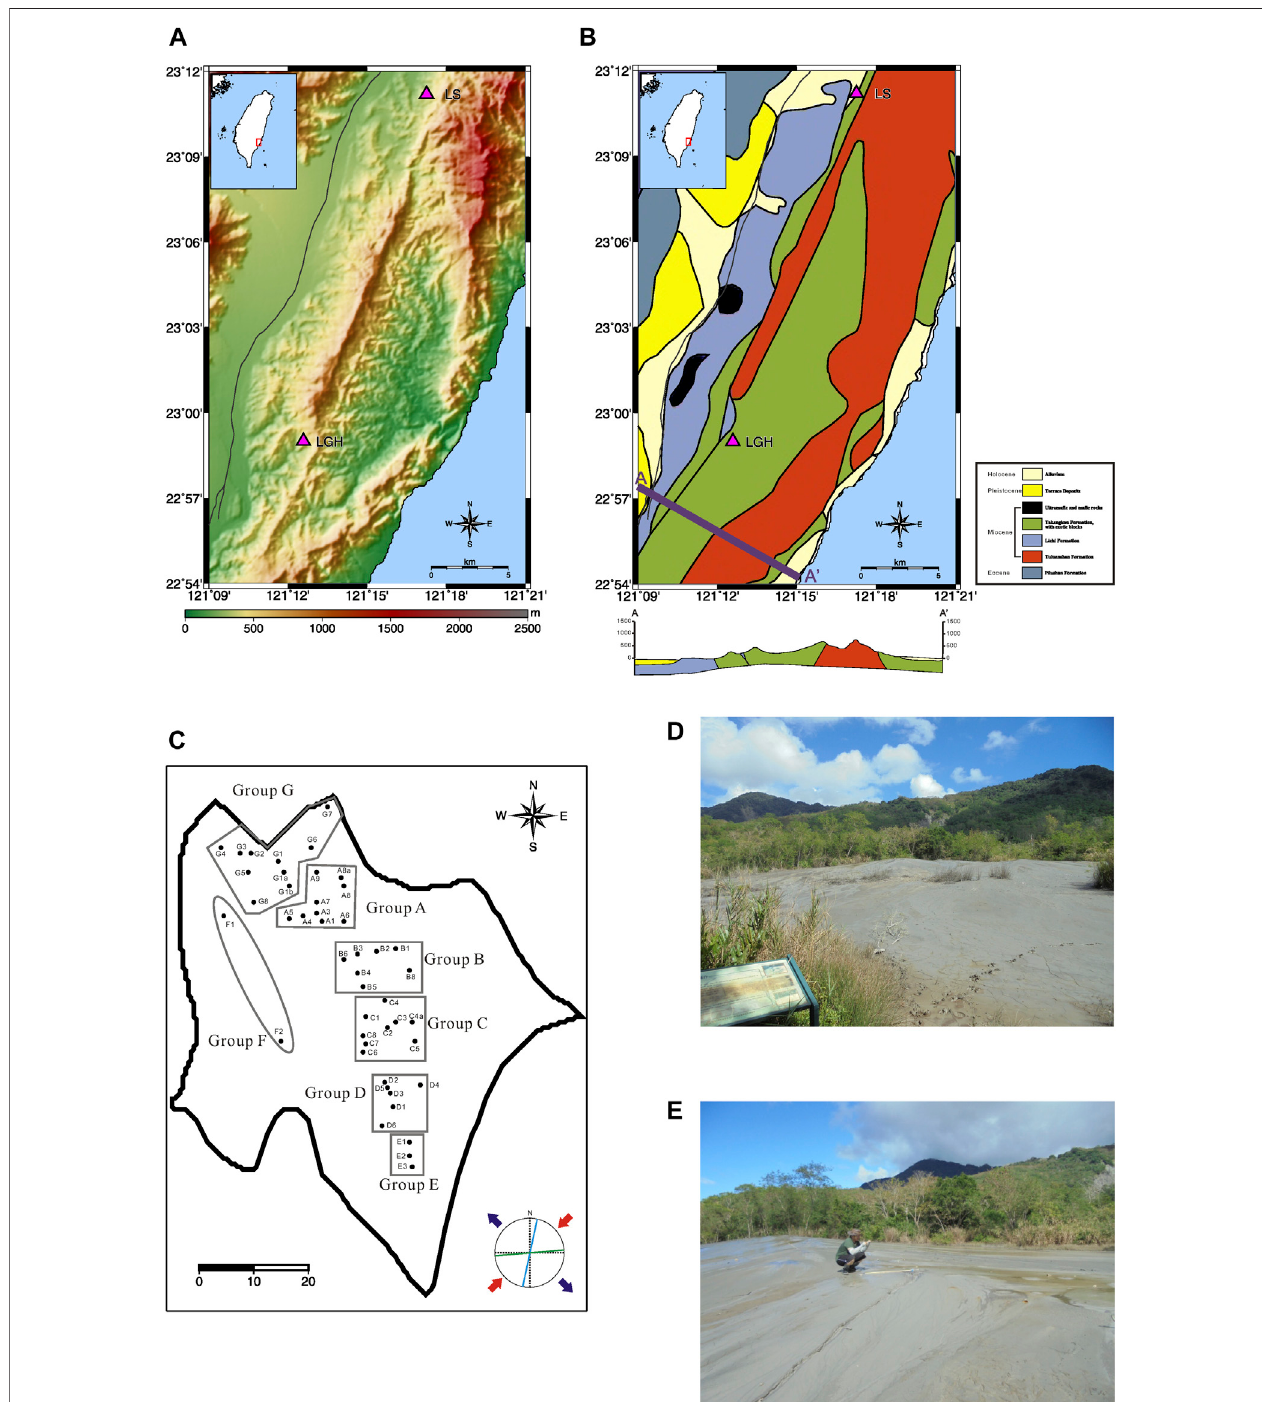
FIGURE 1 | (A) Mud volcano sampling sites (triangles), (B) geologic map adopted from Lin et al. (2008) as well as schematic cross section of A — A ′ pro fi le shows forearc basin, active thrust fault, and andesitic volcanic arc. (C) Mud-covered area of MV LGH (solid line) and the location of each sampled mud pool (black dots). Local fracture analysis in Stereonet after the 2003 M w (cid:1) 6.8 earthquake by Jiang et al. (2011) is shown for reference. (D) Photograph of MV LGH view from the entrance (the westernmost spot) to groups B and C. (E) Photograph taken on the axis of the mud shield, view from group E to group B and C, heading north.